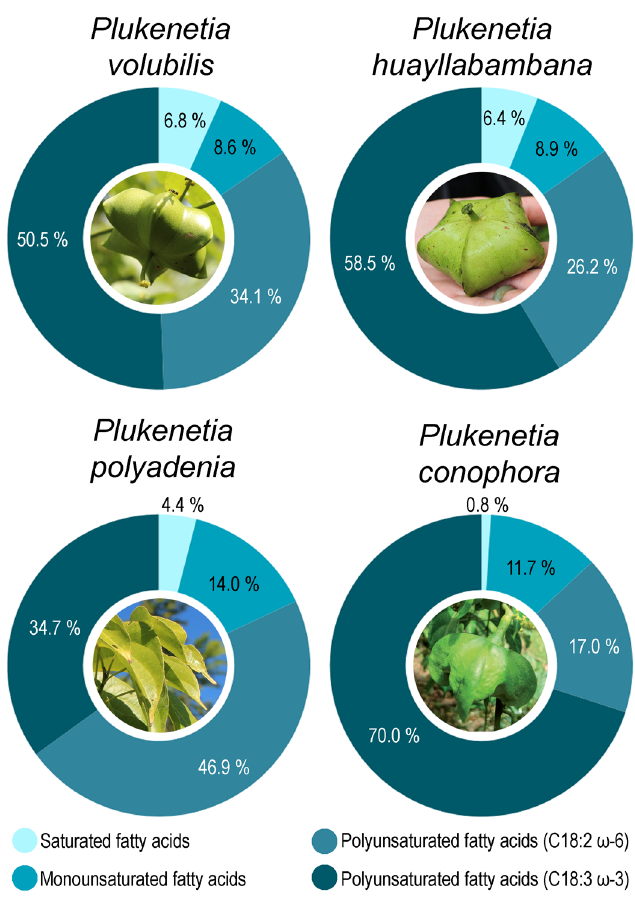
Figure 1. Comparison of the content of saturated, monounsaturated and polyunsaturated (including linoleic acid, C18:2 n-6, ω-6, and α-linolenic acid, C18:3 n-3, ω-3) fatty acids between four of the five large-seeded Plukenetia species known to have been cultivated. Data adapted from 7,14,15,18 . Image of Plukenetia conophora adapted from 13